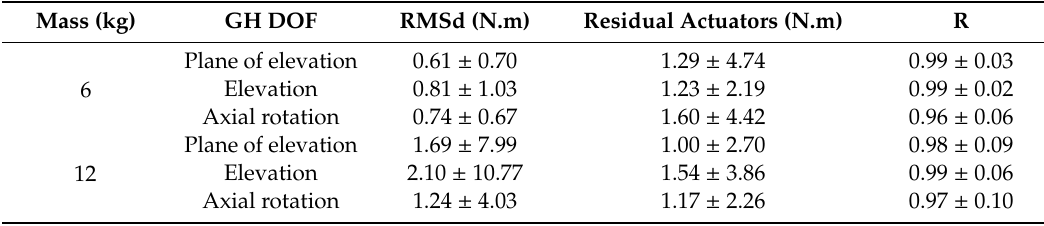
Table 1. RMSd and R between the GH net moment calculated by inverse dynamics and those predicted by the EMG-assisted method, compared to the root mean squared sum of the residual actuators. Mass (kg) GH DOF RMSd (N.m) Residual Actuators (N.m) R Plane of 6